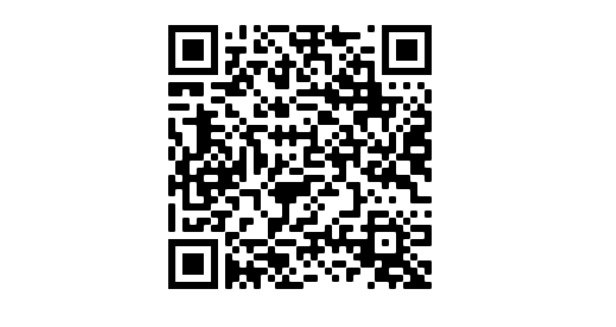
computed tomography scan (C & D,